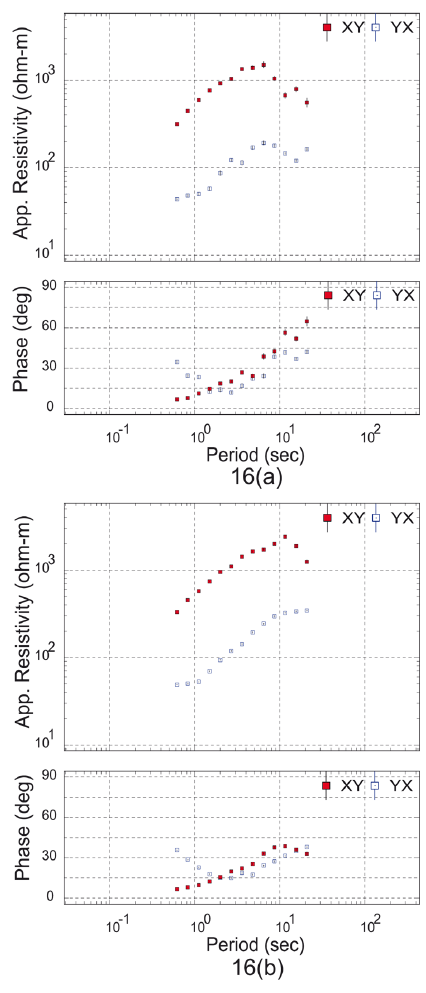
Figure 16. Effect of FFT length on a large data set of 8 Hz of site K11 with 2,473,774 data points. (a) Apparent resistivity (upper panel) and phase (lower panel) curves obtained from the data using a small FFT length 512. (b) Apparent resistivity (top panel) and phase (bottom panel) curves obtained applying a large FFT length of 16384 from the same data set provide a better resolution than the small one. The red colored boxes represent XY components and the blue colored boxes represent YX components of apparent resistivity and phase.